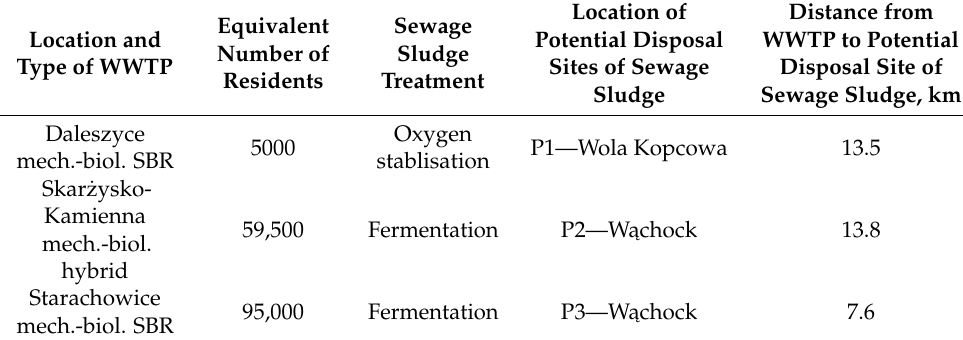
Table 3. Characteristics of wastewater treatment plants [27].